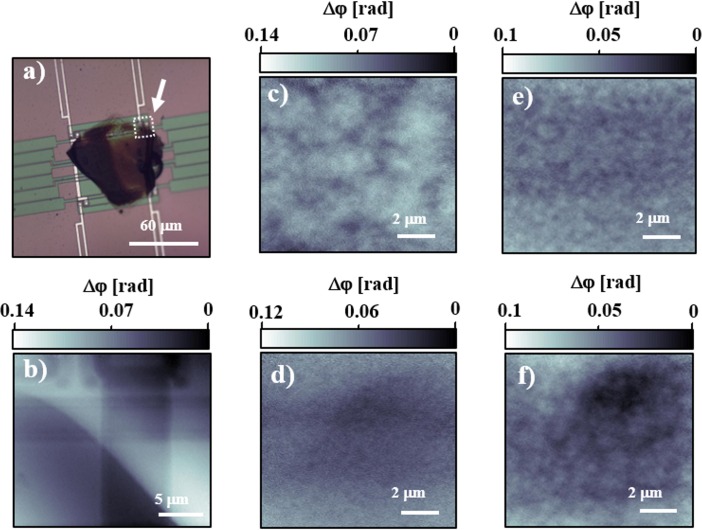
Results obtained with fast-scanning calorimetry sample holder.a) Optical micrograph of the active area on the electronic chip. The central patch is the P3HT-PCBM sample. b-f) Reconstructed phase-contrast high-resolution ptychography projections, with (b) showing the area corresponding to the section marked by the outlined white square in (a). c) Projection for as-cast film, showing that the deposition process has induced a certain morphology. d) Morphology after erasing the thermal history by shortly visiting the melt, showing an essentially featureless image. e),f) Images obtained after 60 s and an additional 660 s (total of 720 s), respectively, of annealing at 400 K, clearly showing that a coarser morphology develops with time. All images were collected at room temperature to reduce problems with radiation damage.